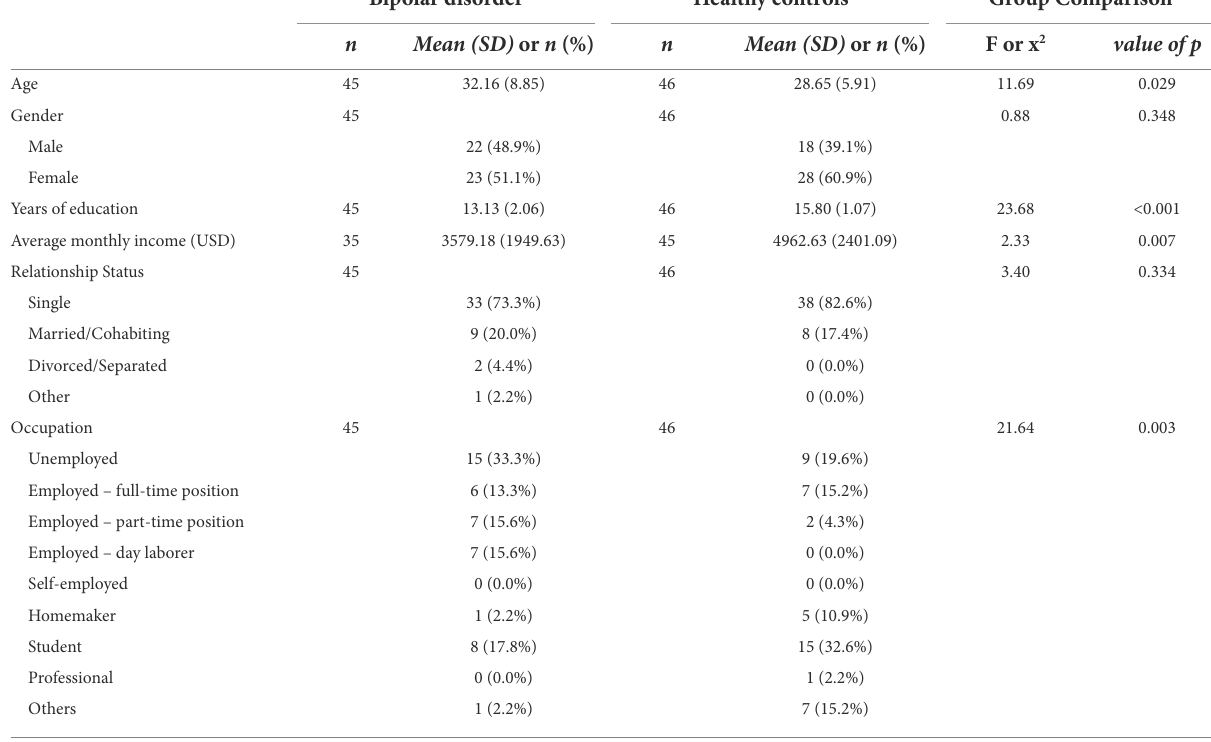
TABLE 1 Sociodemographic characteristics of the clinical sample and healthy